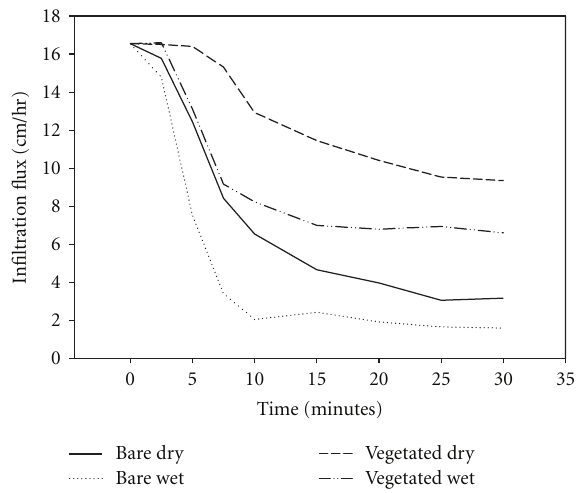
Figure 4: Infiltration flux for Stellar soil with 34Mg biosolidsha − 1 under bare dry, bare wet, vegetated dry, or vegetated wet conditions on the Sierra Blanca Ranch.